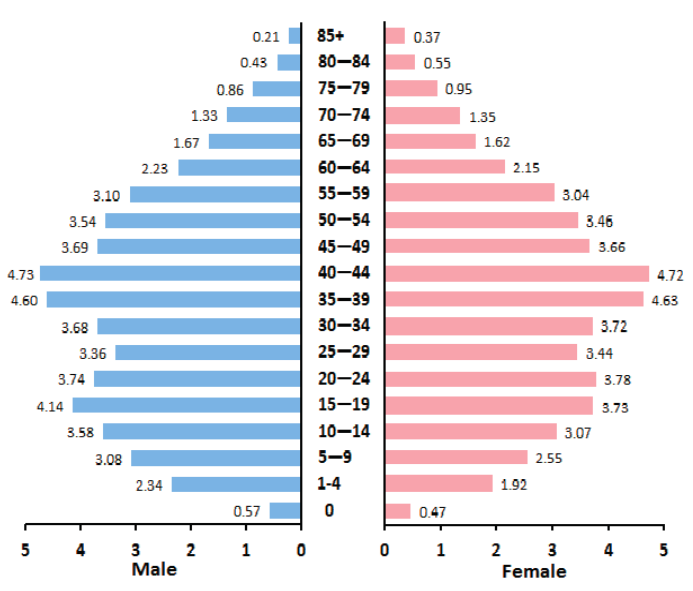
Figure 1. Average distribution of the age-specific population, by sex, in China,